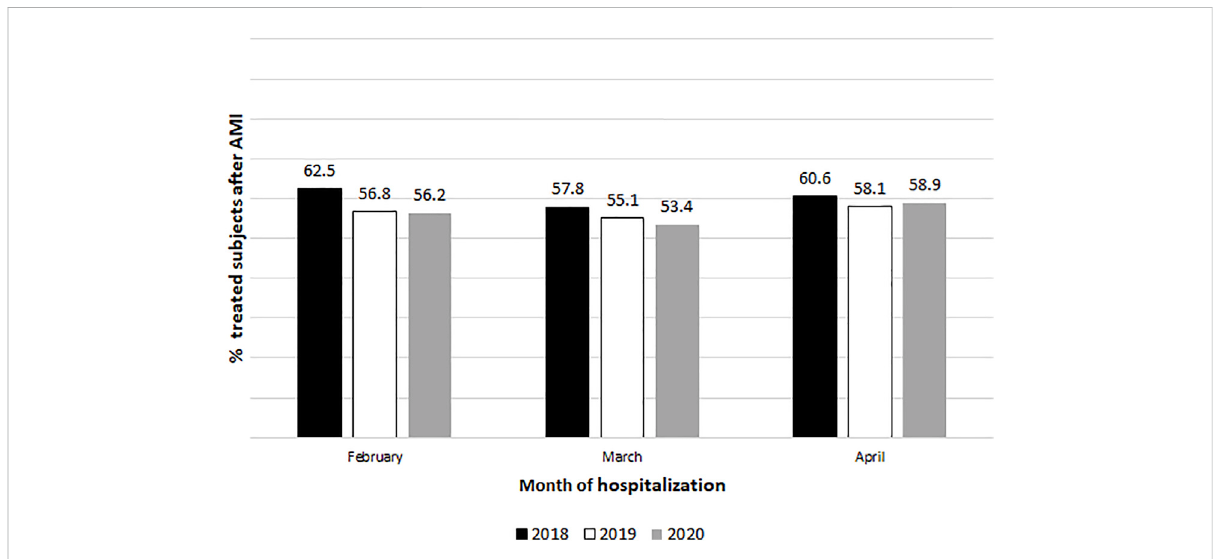
FIGURE 1 Percentage of subjects with a fi rst prescription of beta-blockers in the month after the discharge for AMI